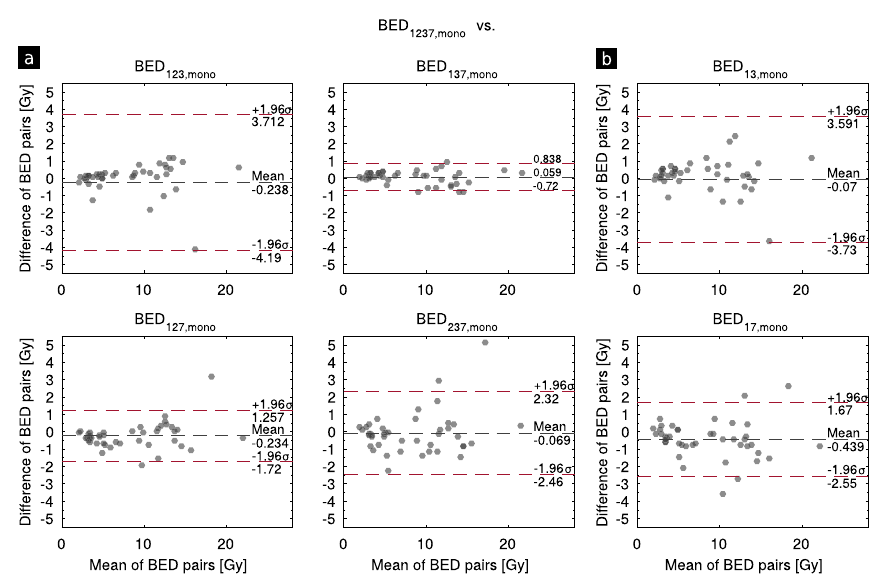
Fig. 3 Bland–Altman plots of the different time samplings with 3 TPs ( a ) and 2 TPs ( b ). Please note that for days 1, 2, 3 and 1, 3 there is one outlier lesion with a BED difference of For scaling reasons, they are not shown in these plots but are provided in Additional file 1